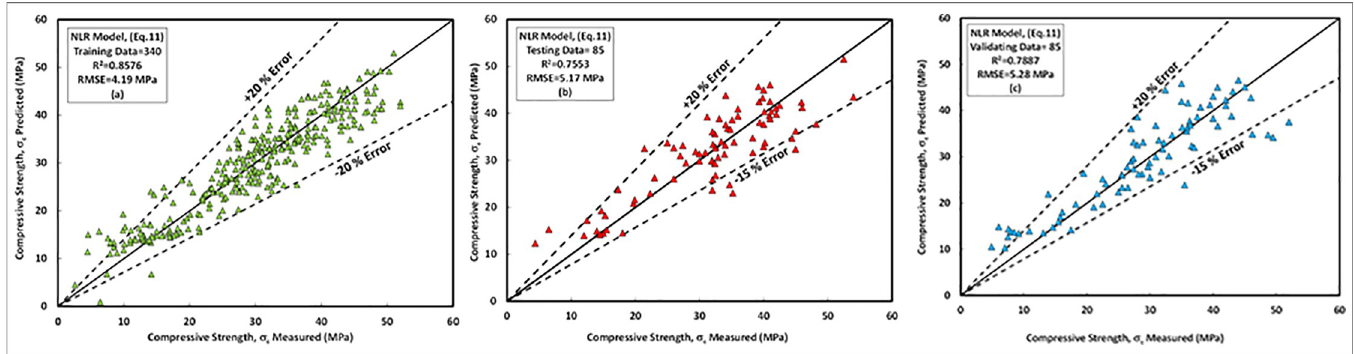
Fig 18. Comparison between measured and predicted compressive strength of fly ash-based geopolymer concrete mixture using NLR model, (a) training data, (b) testing data, (c) validating data.